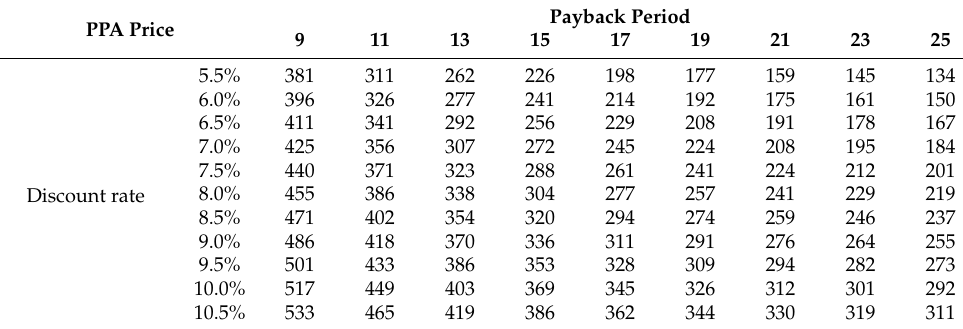
Table 5. Correlation Analysis of Discount Rate, Payback Period, and PPA Price.